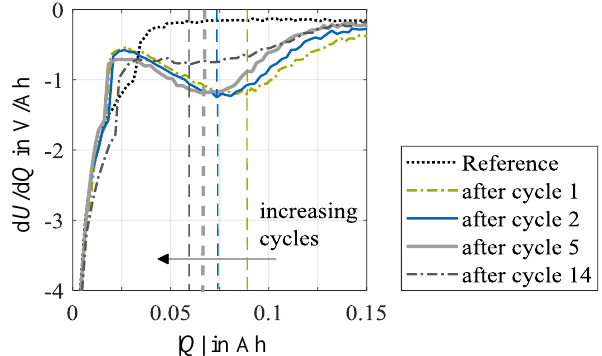
Figure 5. DVA of stripping discharges at 0 °C after load cycles 1, 2, 5 and 14 at test points with a charge rate of 1.5C. The vertical lines indicate the local minima in the DVA spectra. The reference data exemplifies the unaged condition of once cell specimen used in this test series at check-up test 0.